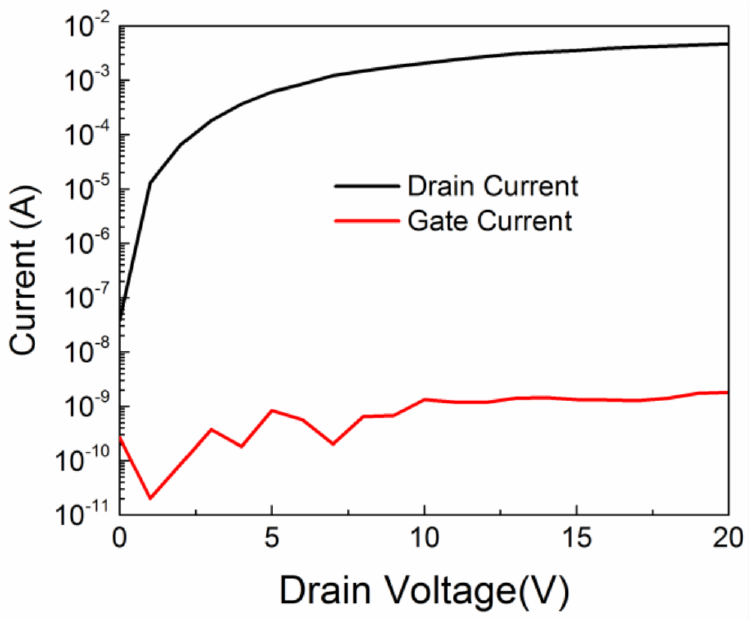
Figure 15. The gate and drain currents of the device after heavy-ion